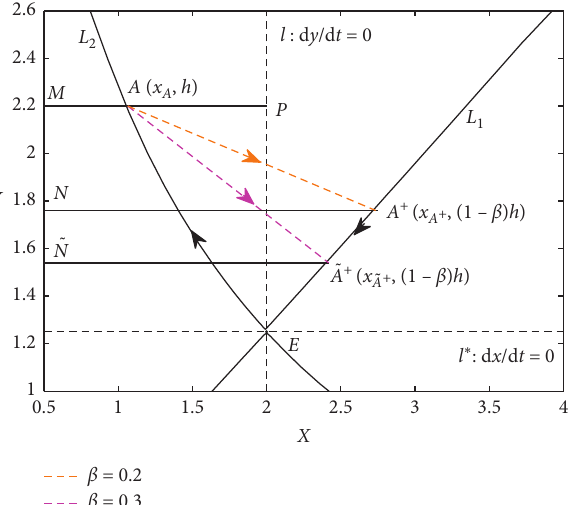
Figure 8: Homoclinic cycle of model (2) when α � 1 with parameter values: a � 5 ,c � 4 , d � 6 , e � 3 , and h � 2 . 2. The case of β � 0 . 2 is shown in hazel line while that of β � 0 . 3 is exhibited in pink line.